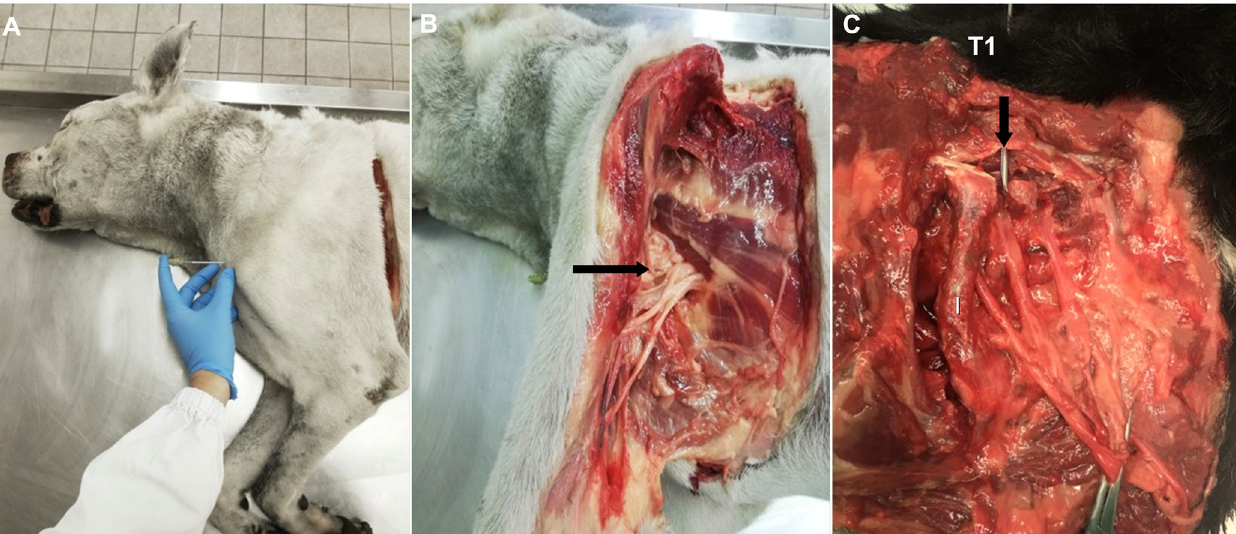
Fig 2. The depth of the nerves forming the brachial plexus was investigated. (A) With the aim of measuring the distance of the T1 from the skin at the level of the shoulder joint, a needle was inserted just above the shoulder tip toward the cranial border of the first rib, parallel to the long axis of the body. (B) The proper positioning of the needle was verified by direct visualisation of the root of the T1, slightly lifting the limb in a craniolateral direction. (C) The limb was removed, and the distance of the nerve roots from the skin of the interscapular region was evaluated. The needle (arrow) was inserted perpendicularly to the vertebral column 2 to 3 cm laterally, and 1 to 2 cm cranially and caudally to the spinous process. T1: indicates the spinous process of the first thoracic vertebra. I: indicates the first